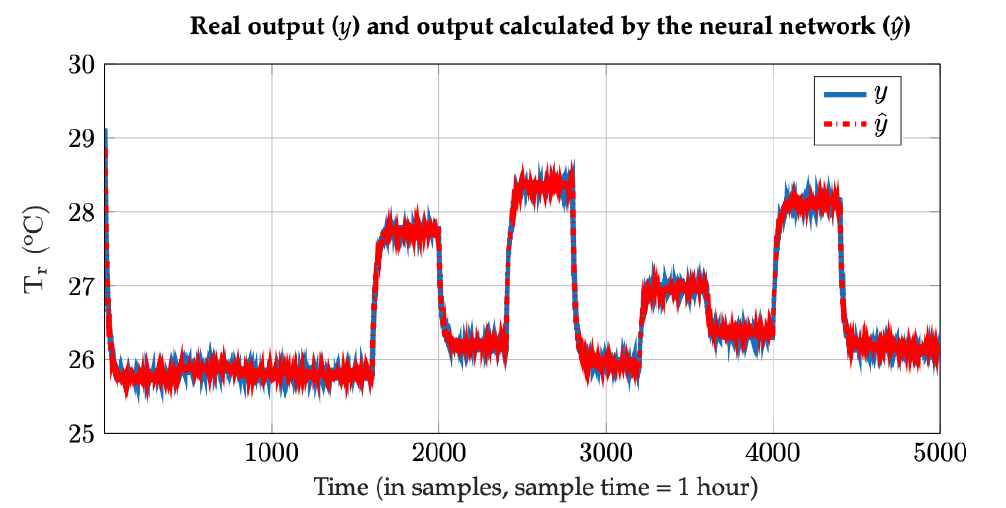
Figure 8. Comparison between the real output ( y ) and the predicted output ( ˆ y ) by the neural network for the Yeast Fermentation Reactor Temperature.